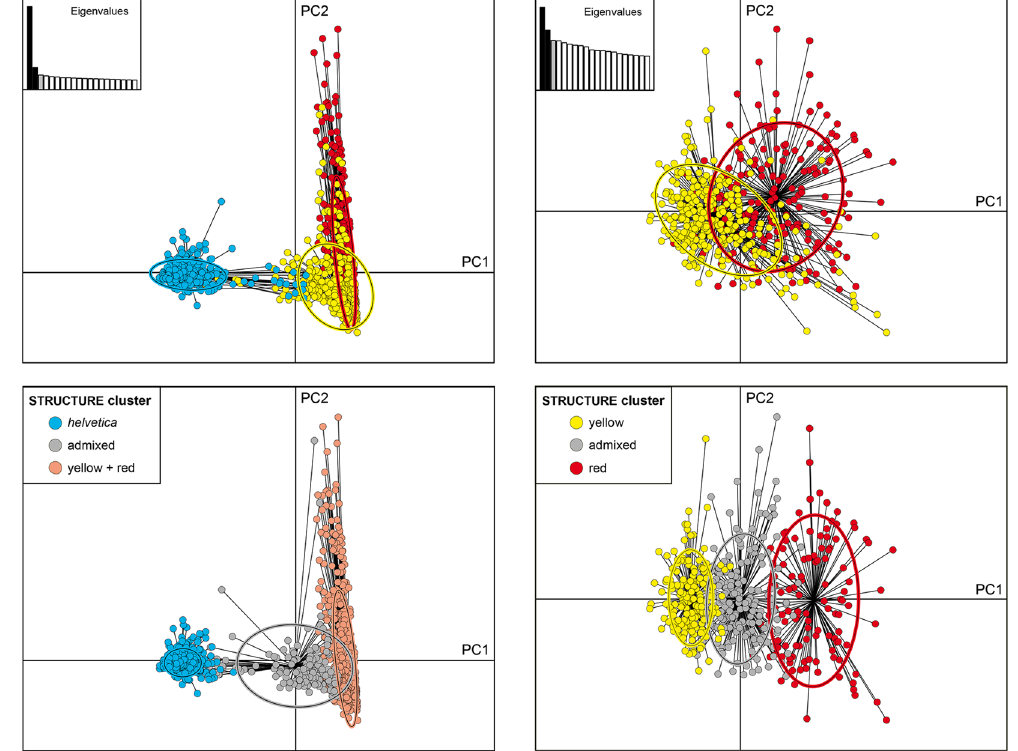
Figure 4. PCA axes 1–2 for microsatellite data. Samples are coloured according to mitochondrial lineages (top) or structure clusters (bottom). Admixed individuals were identified according to hybridlab results. PCAs for the yellow and red lineages correspond to the samples from Fig. 3c. Non-native samples were excluded. The oval outlines represent 95% confidential intervals. For helvetica and the eastern lineages (left) the x axis explains 16.6% and the y axis 4.5% of variation. For the eastern lineages (right) the x axis explains 3.8% and the y axis 2.9% of variation. Analyses along axes 1–3 produced nearly identical results (see Supplementary Fig.